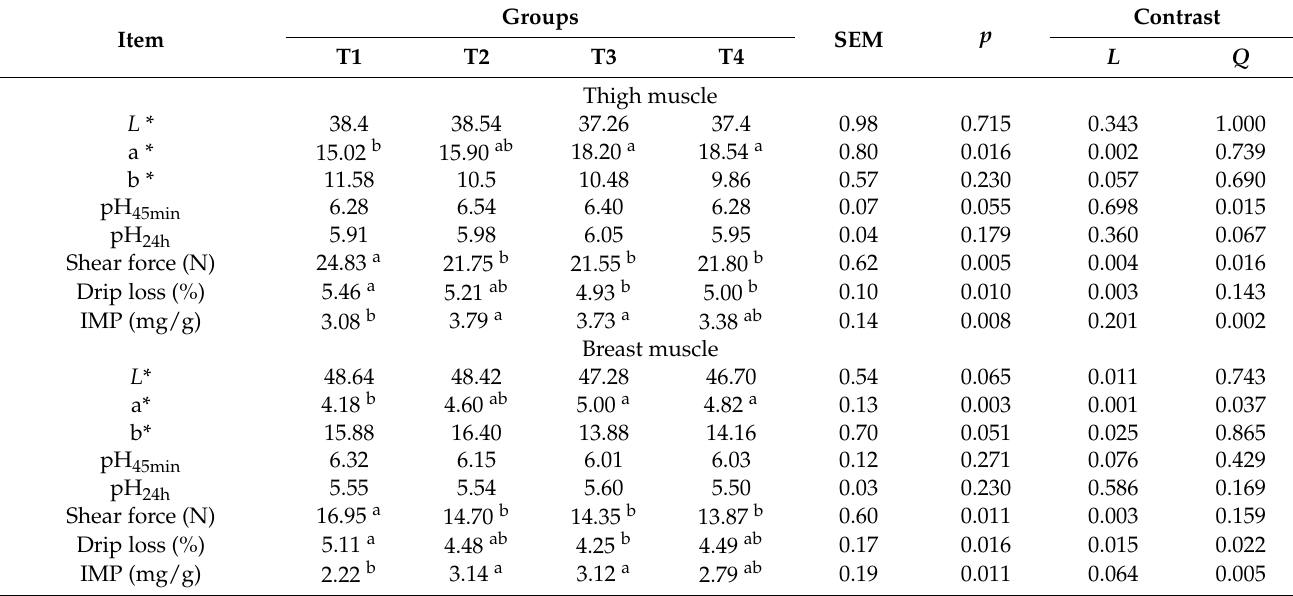
Table 3. Effects of Ampelopsis grossedentata extract on meat quality of